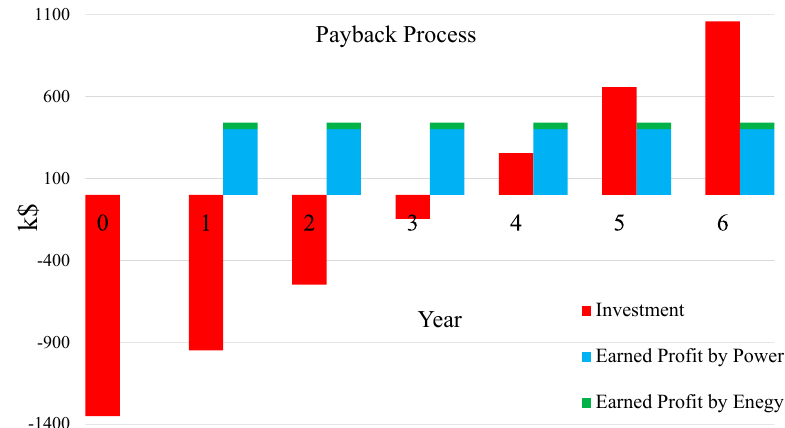
Figure 15. Payback process based on annual earning for the 5-STS crane group.